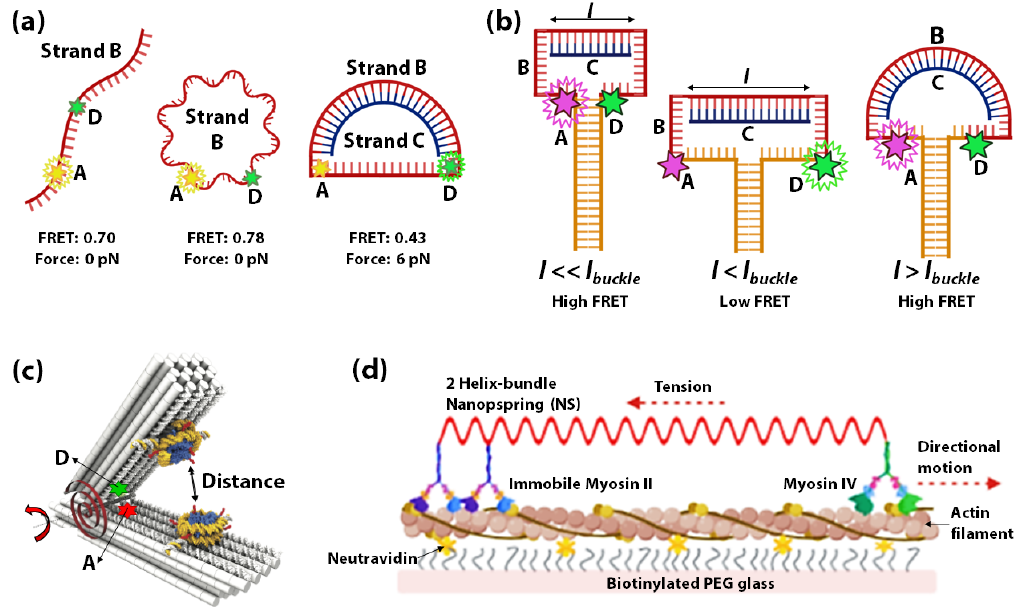
Figure 3. Schematic representation of force exerted by DNA spring (B / C duplex) on ( a ) the single-stranded part of circular ssDNA B [129] and ( b ) the stem of hairpin B [130]. Increasing force increases the distance between the fluorophores D and A, resulting in a decrease in FRET (by unzipping in case of ( b )). ( c ) Schematic representation of the DNA origami-based force-spectrometer consists of a spring-loaded hinge bearing two attached nucleosomes and a FRET pair of acceptor (A) and donor (D) fluorophores. The red torsional spring depicts the torque generated by the hinge. The nanospring is used for sensing distance (and interactive forces) between nucleosomes. Figure adapted with permission from [132]. Copyright 2016, the authors. ( d ) Schematic representation of a two-helix bundle DNA nanospring tethered to immobilized myosin II on one end and myosin VI on the other. Myosin VI is shown to more unidirectionally along actin filament against the load of the DNA nanospring. [133]